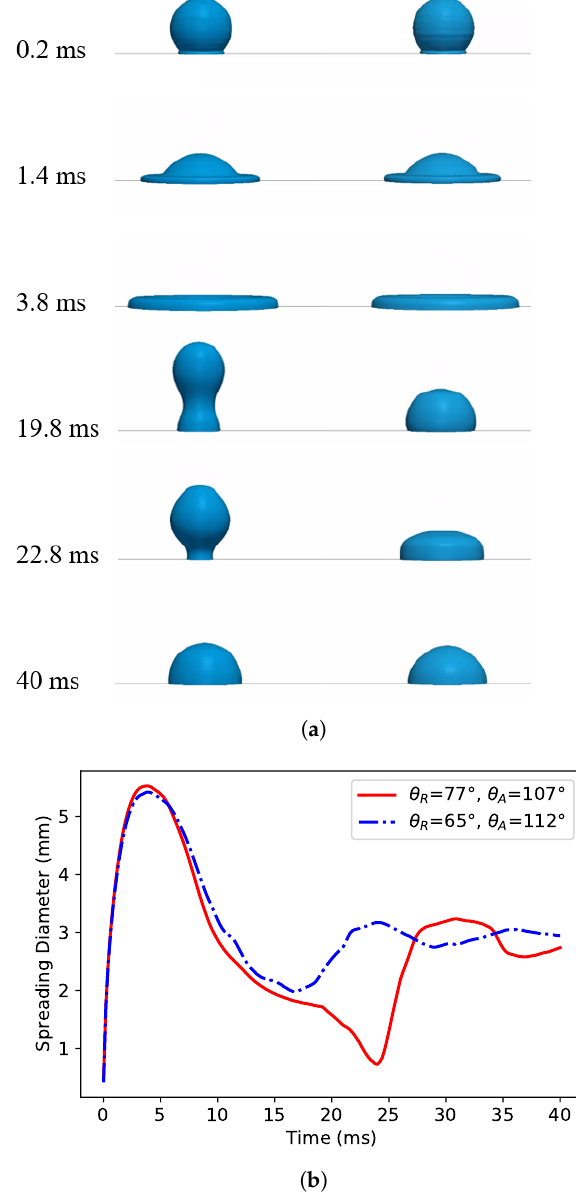
Figure 5. Effect of the contact angle hysteresis on droplet impact on a surface with the same equilibrium (or static) contact angle of θ E = 90 ◦ , with droplet ( a ) snapshot and ( b ) spreading diameter. ( a ) Transient profile evolution for (left) θ R = 77, θ A = 107 and (right) θ R = 65, θ A = 112. ( b ) Spreading diameter